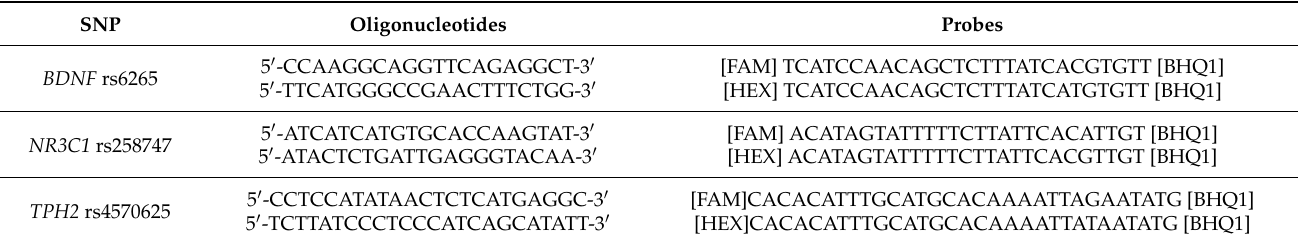
Table 2. Oligonucleotide and TaqMan probe sequences used for real-time PCR analysis of rs6265, rs258747, and